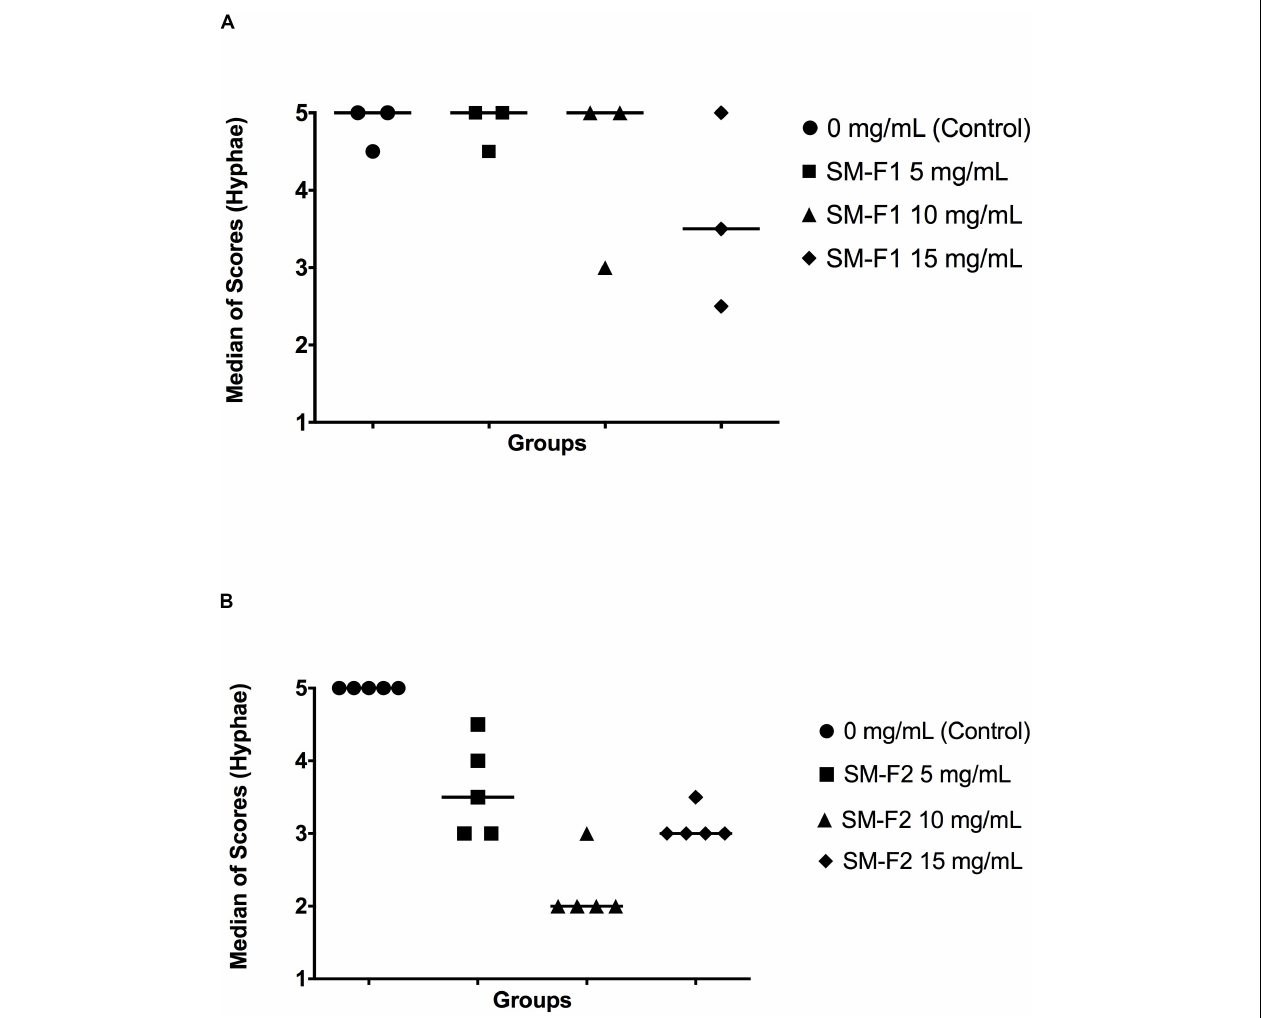
FIGURE 2 | Quantitative analysis of Candida filamentation. Median scores obtained by counting hyphae counting. Scores were assigned according to the number of hyphae in each microscopic field. (A) C. albicans cultured with PBS (control group), SM-F1 5 mg/mL, SM-F1 10 mg/mL, and SM-F1 15 mg/mL. No statistically significant differences were found between groups. (B) C. albicans cultured with PBS (control group), SM-F2 5 mg/mL, SM-F2 10 mg/mL, and SM-F2 15 mg/mL. Statistically significant difference was observed only between the control group and SM-F2 10 mg/mL ( p = 0.004). Kruskal-Wallis and Dunn’s test.